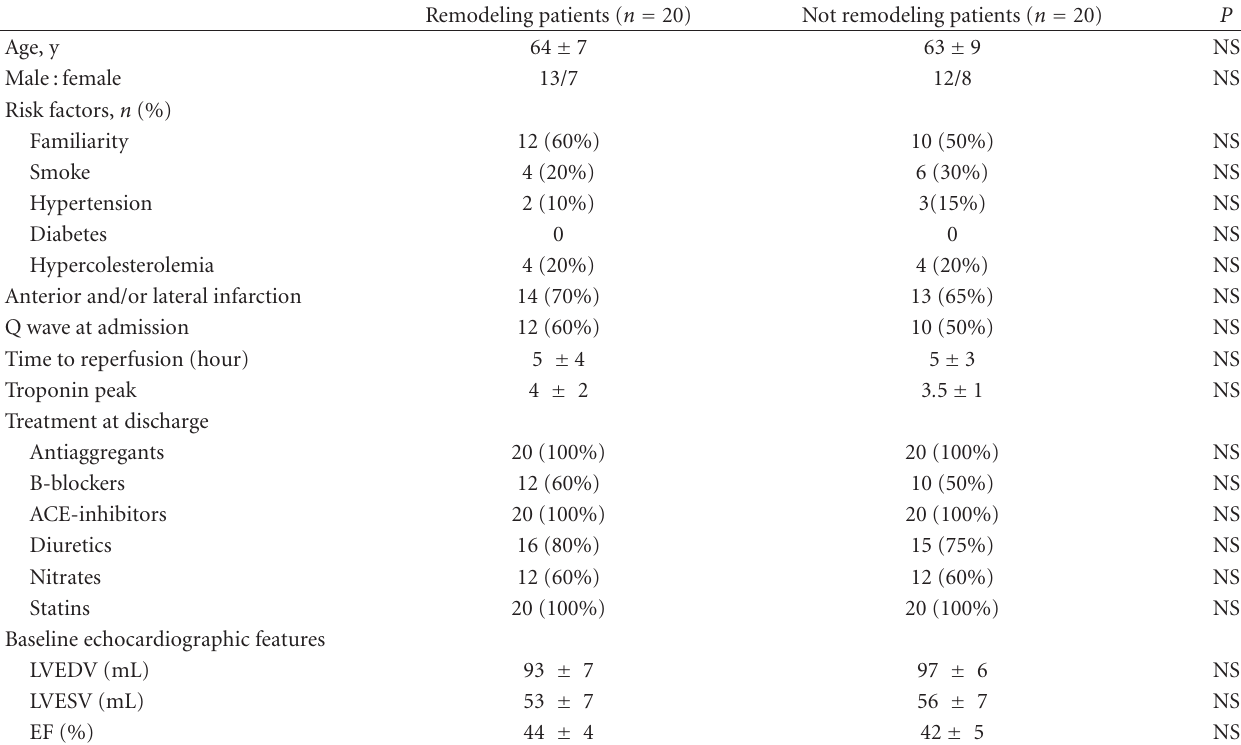
Table 1: Baseline characteristics of patients.